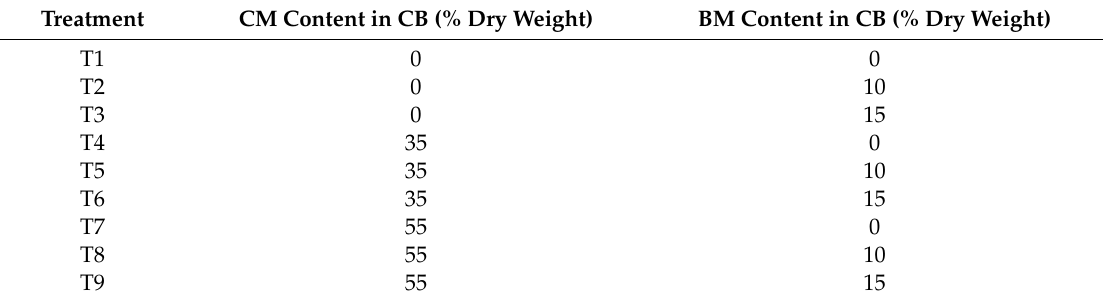
Table 1. The proportion of cow manure (CM) and bovine bone meal (BM) in % dry weight added to the various treatments of this